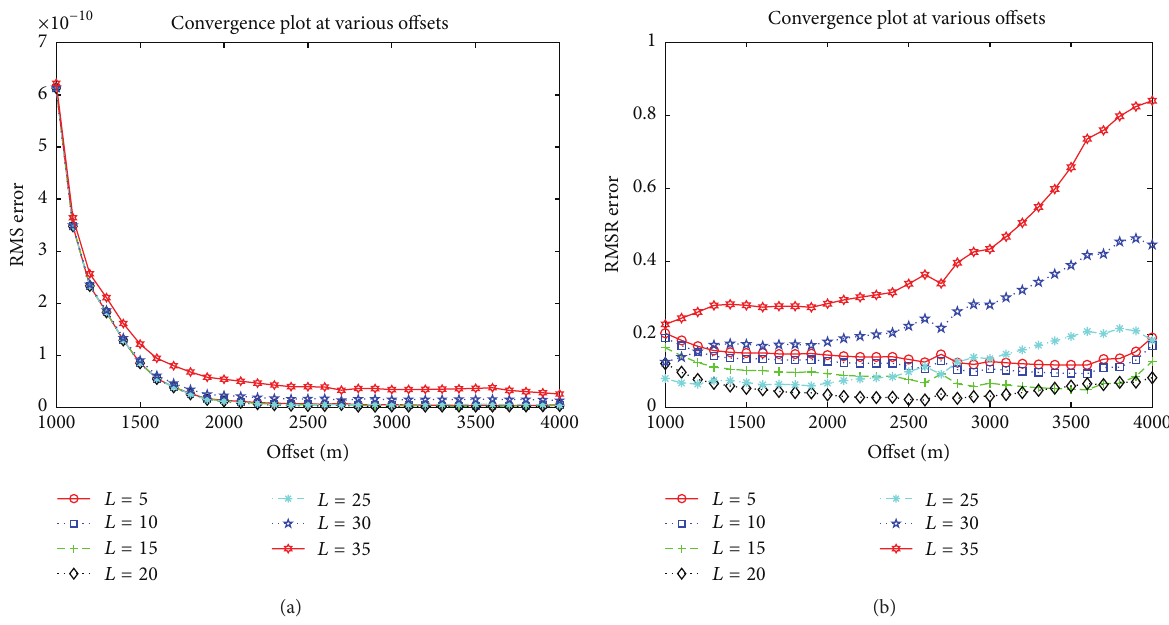
Figure 9: Convergence plot obtained by varying the size ( 𝐿 ) of the UPML region and the main medium at various offsets.